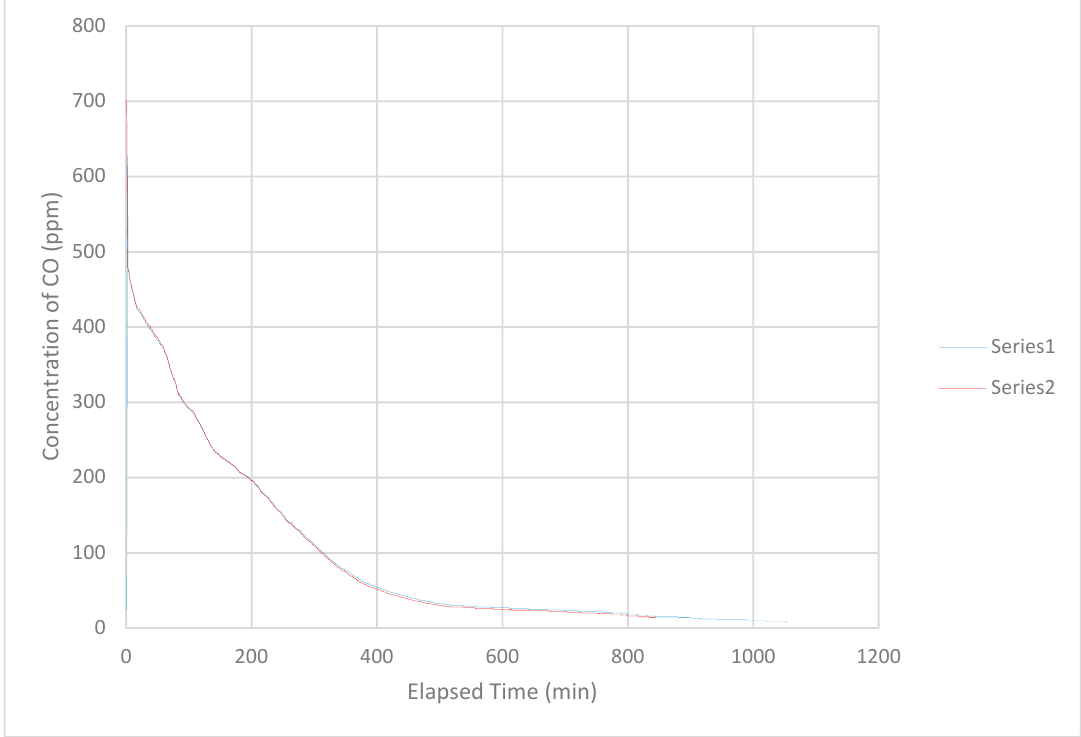
Figure 6. Rapid vertical (almost instantaneous) decrease in concentration of CO occurred during the first minute(s) of this test (9 November 2015). Series 1 to Series 3 reflected the position of the instruments on the stand at 152 cm (60 in), 114 cm (45 in), 76 cm (30 in), and 38 cm (15 in) above the bottom, respectively. The curves superimpose onto each other. Note: Output from only two instruments was available on this day.